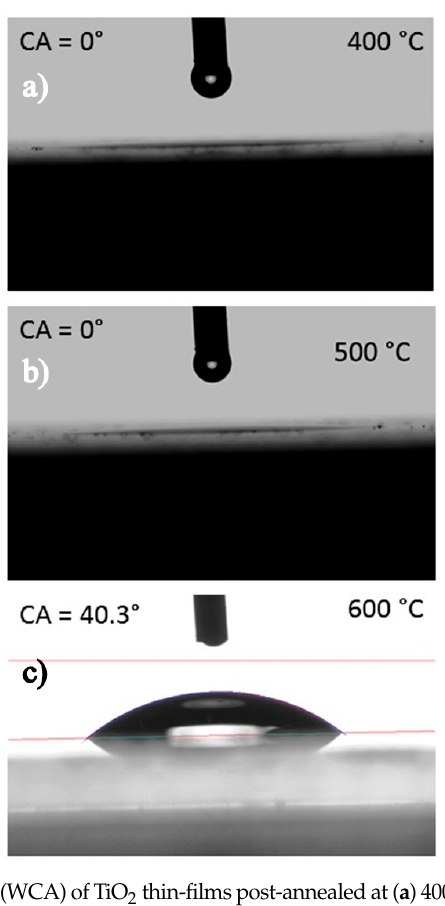
Figure 7. Water contact angle (WCA) of TiO 2 thin-films post-annealed at ( a ) 400 ◦ C, ( b ) 500 ◦ C and ( c ) 600 ◦ C.